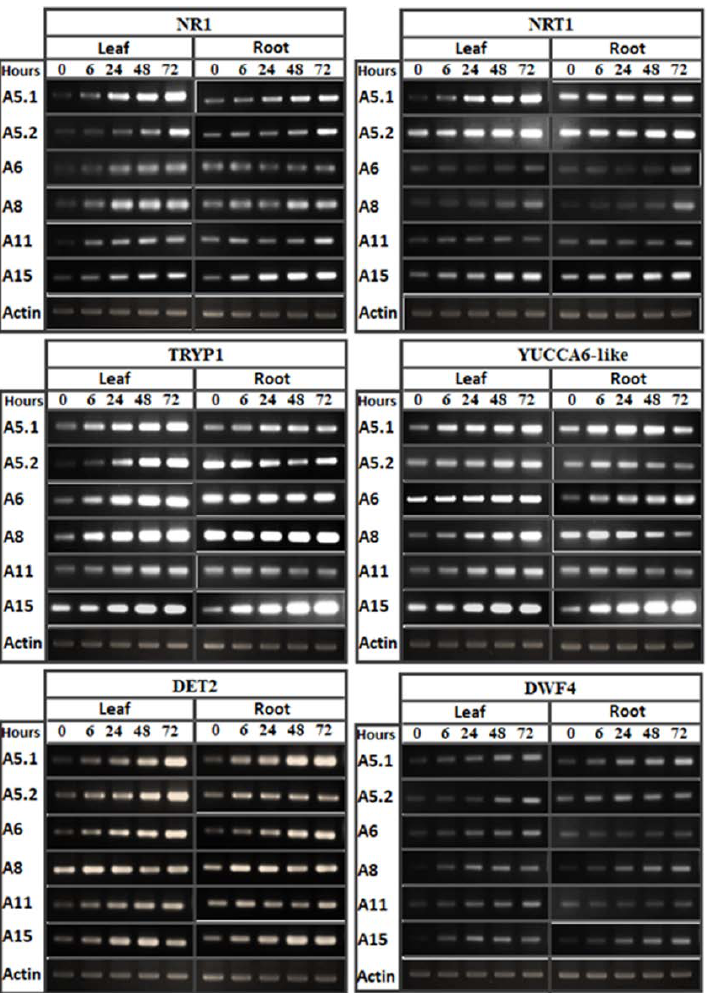
Figure 8. RT-PCR analysis showing the effect of culture filtrates on gene expression implicated in nitrogen-metabolism (NR1, NRT1), auxin biosynthesis (Tryp1, YUCCA6-like) and brassinosteroid biosynthesis (DET2, DWF4). The RT-PCR was performed in leaf and root at 0, 6, 24, 48, and 72 h of filtrate application. Actin gene was used as